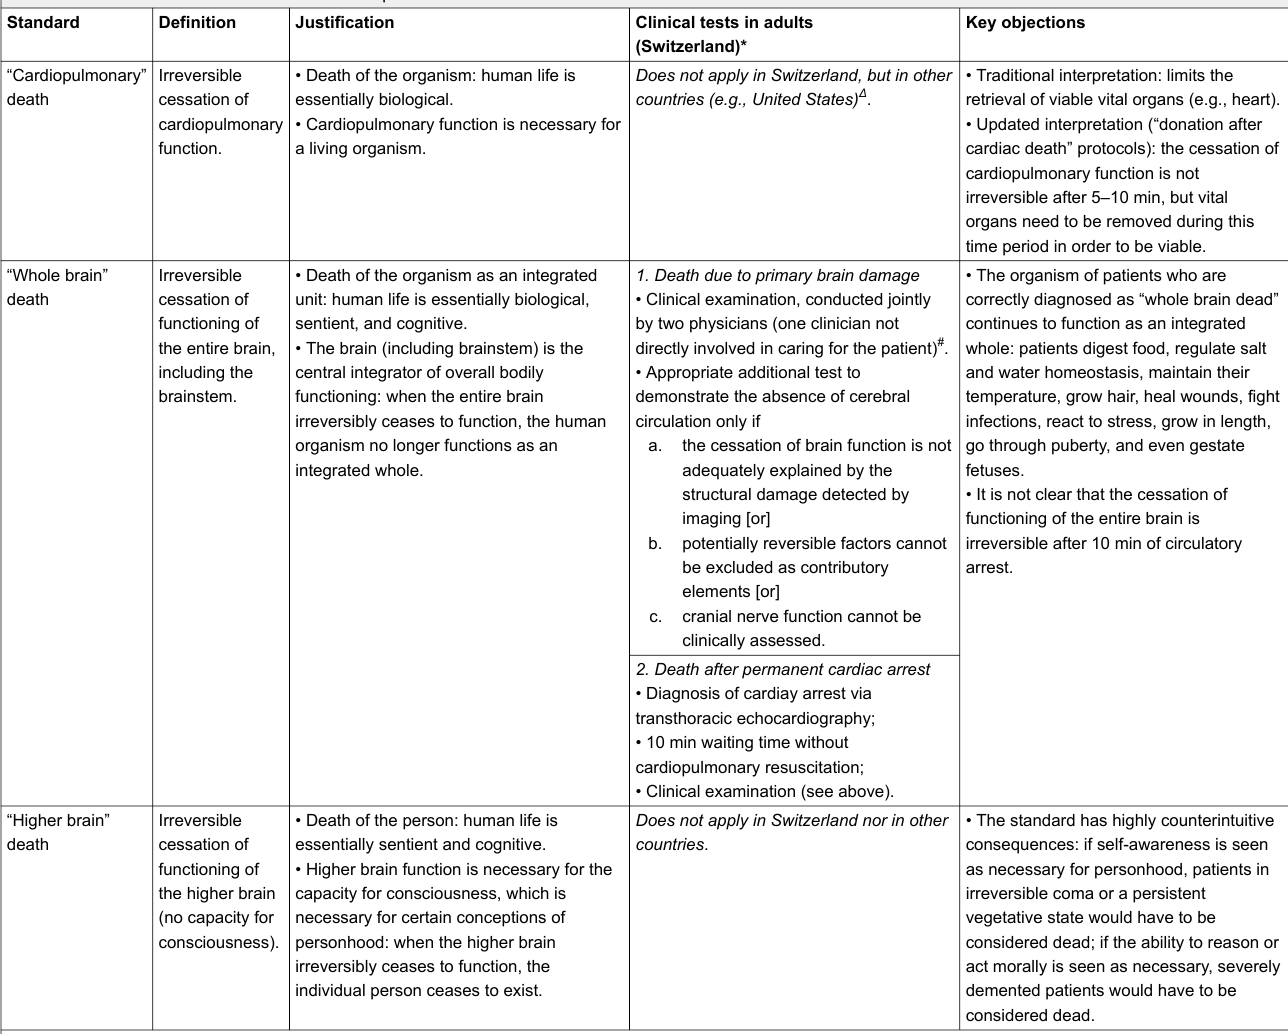
Table 1: Standards of death in the context of transplantation medicine.